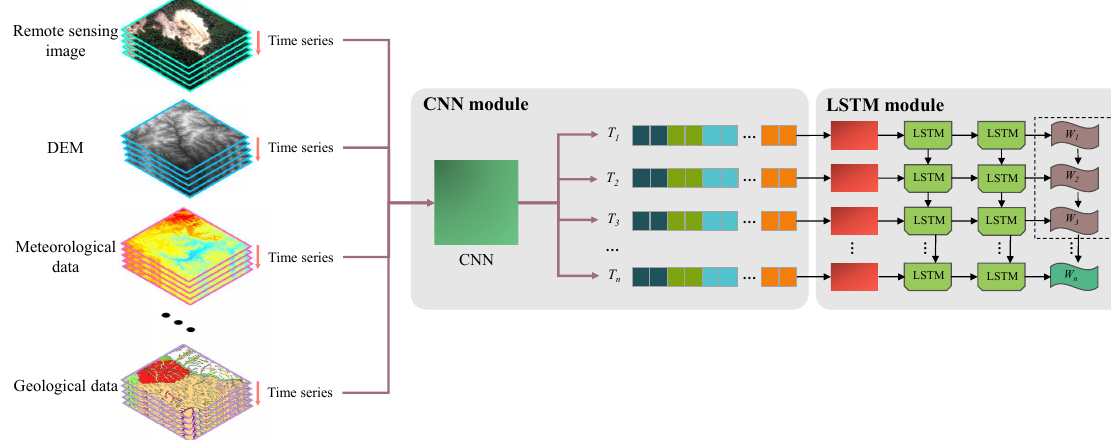
Figure 2. CNN-LSTM module structure